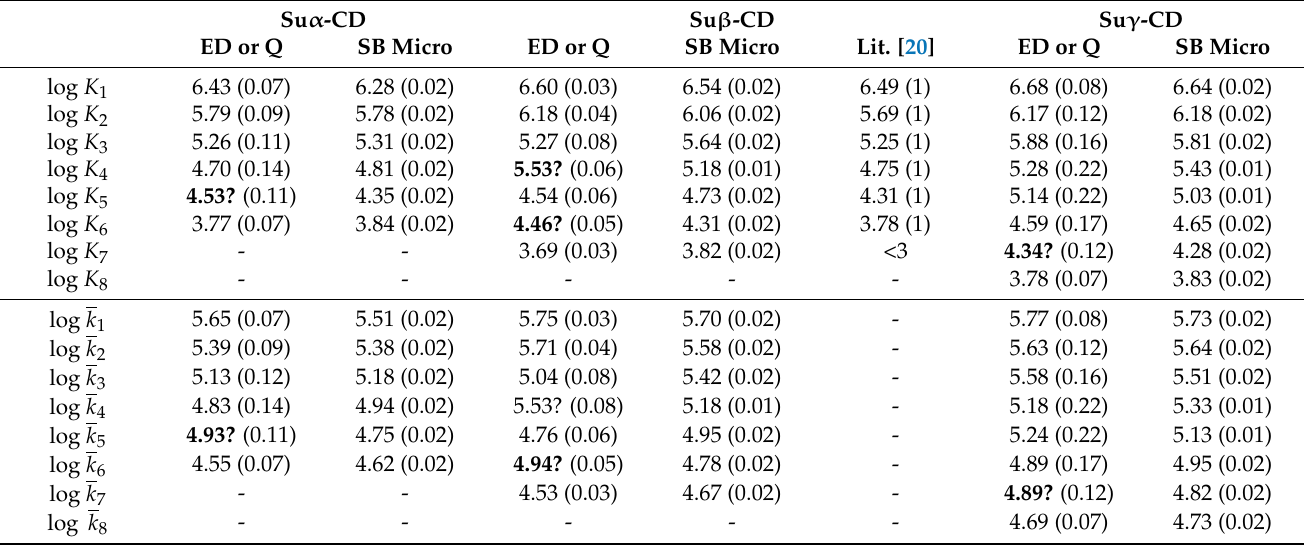
Table 1. Macroscopic and averaged microscopic protonation constants of the studied cyclodextrin derivatives, with their standard deviations in parentheses. The ED macro and the Q-fitting evaluation approaches gave physically unrealistic values for some microconstants (suggesting cooperative proton uptake), the affected macro- and microconstants are marked by question marks. The site- binding microscopic evaluation yielded the correct protonation constants, whose errors were assessed by Monte Carlo